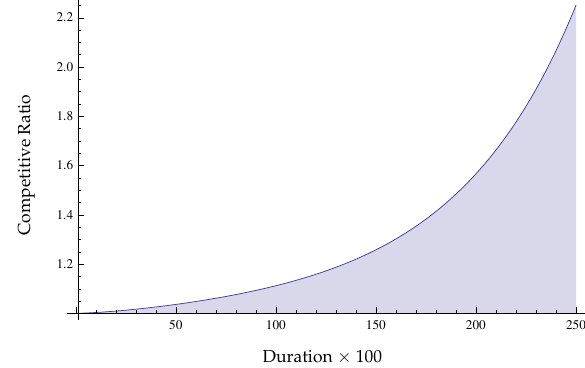
Figure 10. Competitive ratio linear